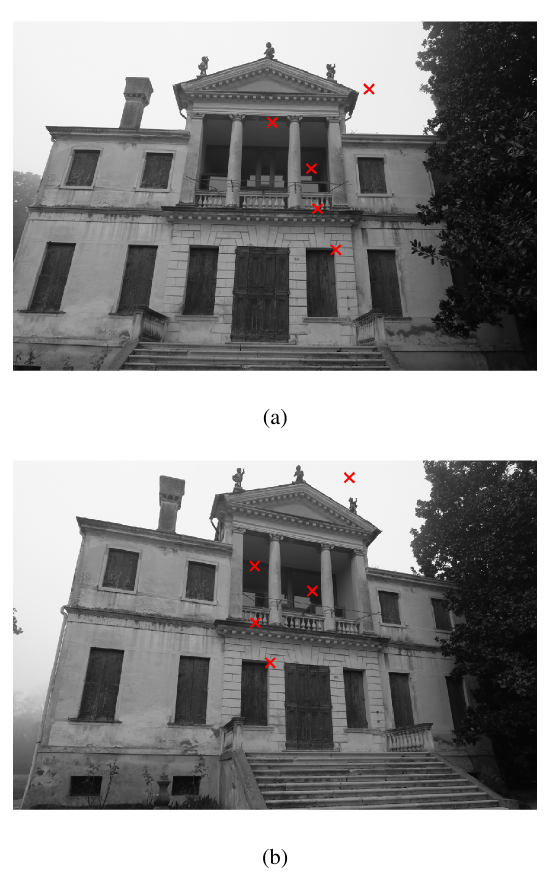
Figure 3. Wrong feature matches detected by using an approximate epipolar constraint.